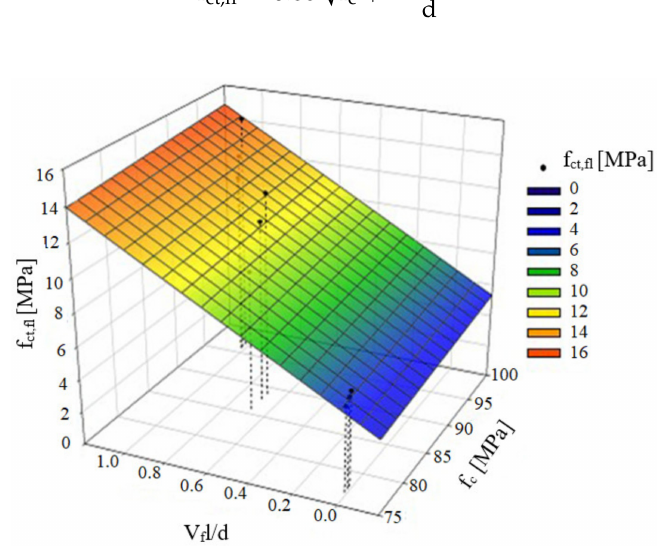
Figure 5. Flexural tensile strength results (f ct,fl ) depending on compression strength (f c ) and fibre reinforcement ratio (V f l /